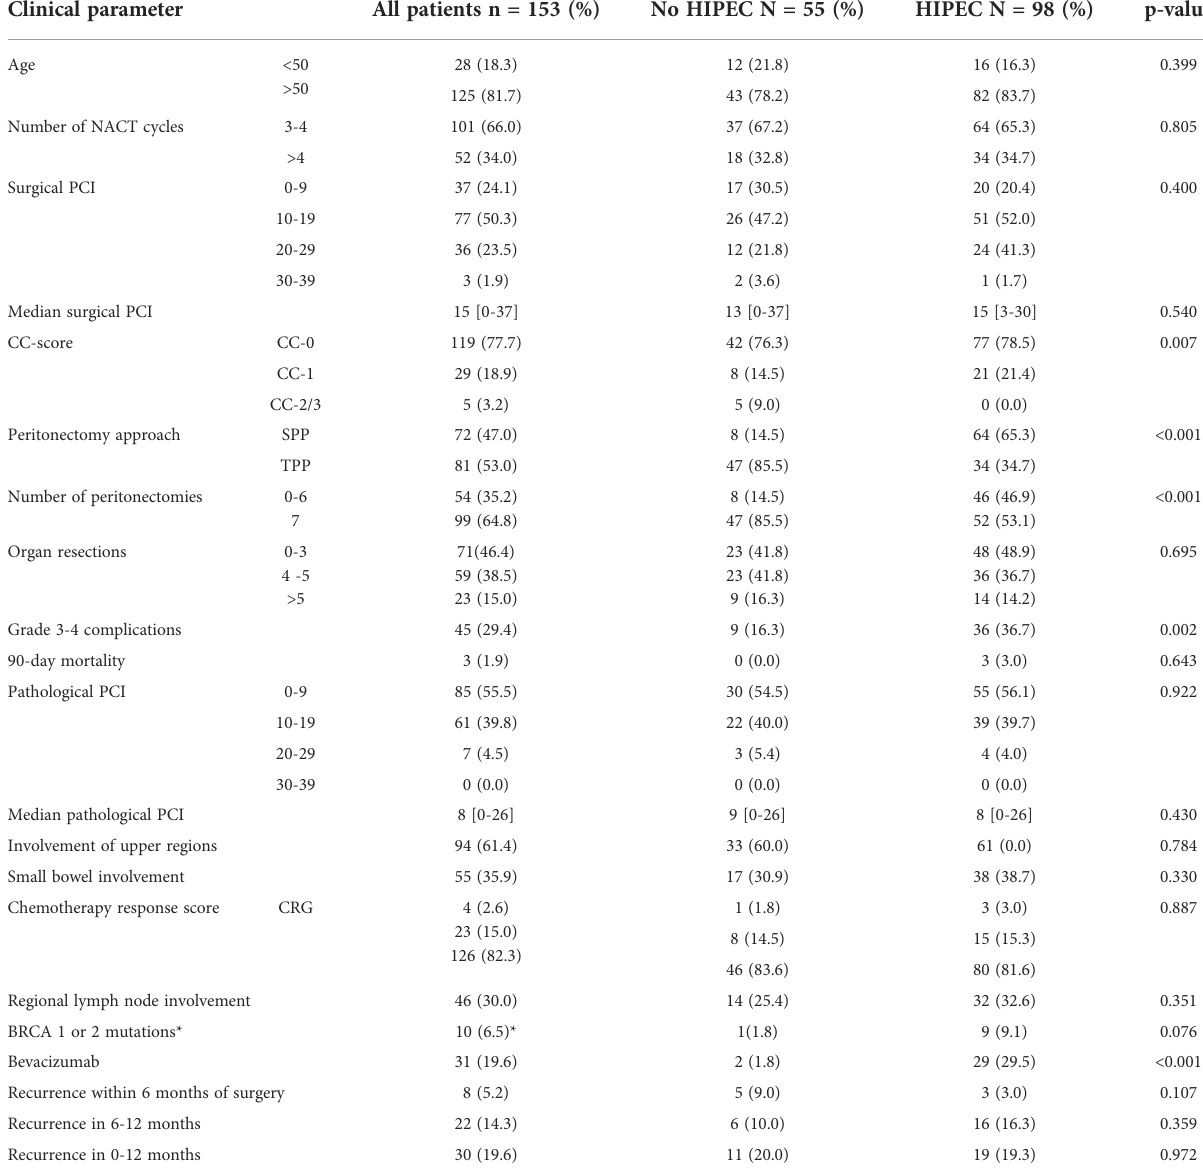
TABLE 1 Comparison between patients treated with or without HIPEC. Clinical